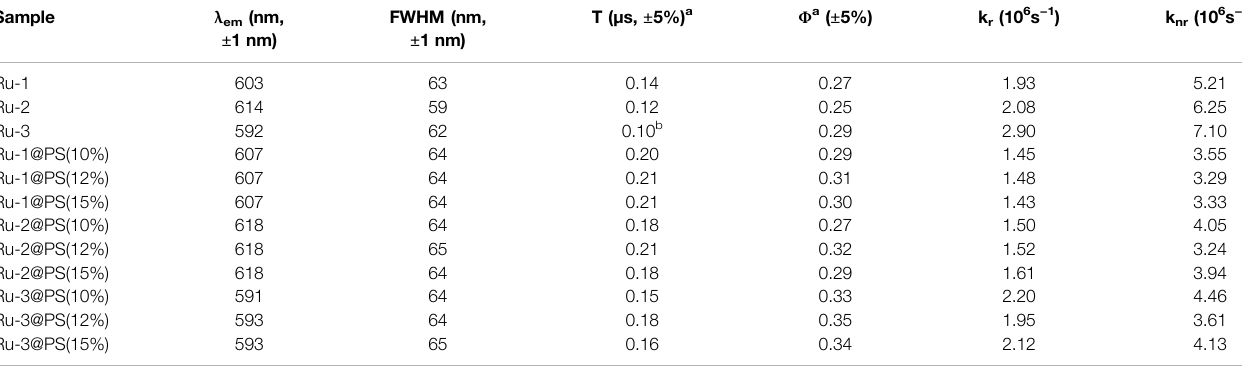
TABLE 1 | Photophysical parameters of Ru-n complexes and Ru-n@PS fi bers in the solid state.